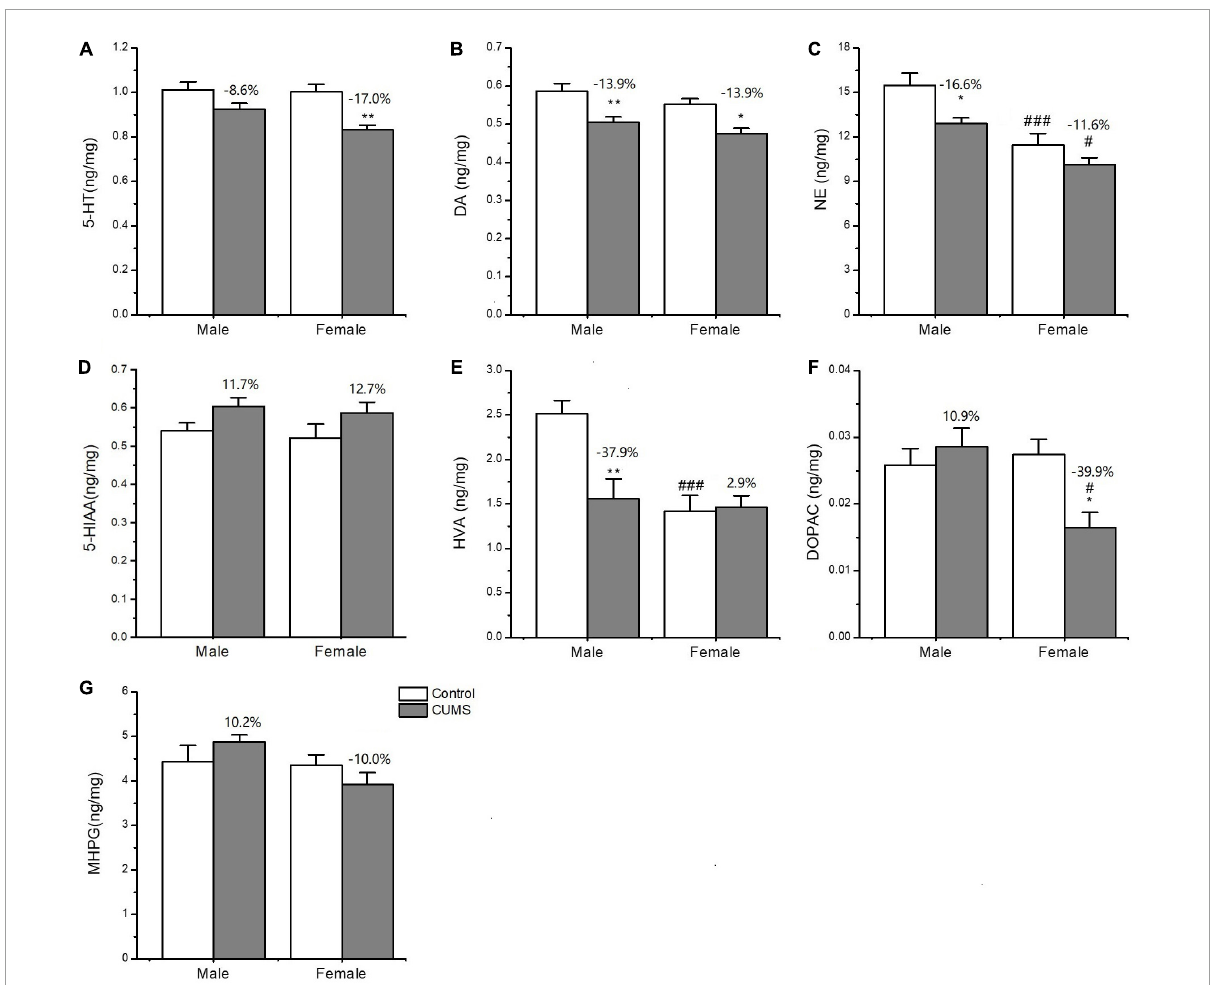
FIGURE9 The concentrations of neurotransmitters and metabolites in the hippocampus of male and female rats. (A–G) The concentrations of neurotransmitters and metabolites detected in the hippocampus. 5-HT, DA, NE, 5-HIAA, HVA, DOPAC, and MPHG. * p < 0.05, ** p < 0.01 vs. control with same sex, # p < 0.05, ### p < 0.001 vs. male in same control or CUMS